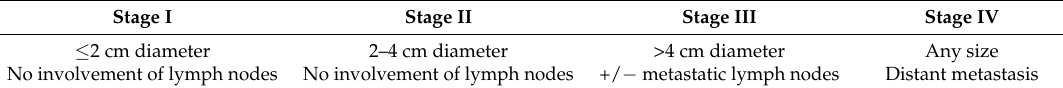
Table 1. World Health Organization staging system for canine oral malignant